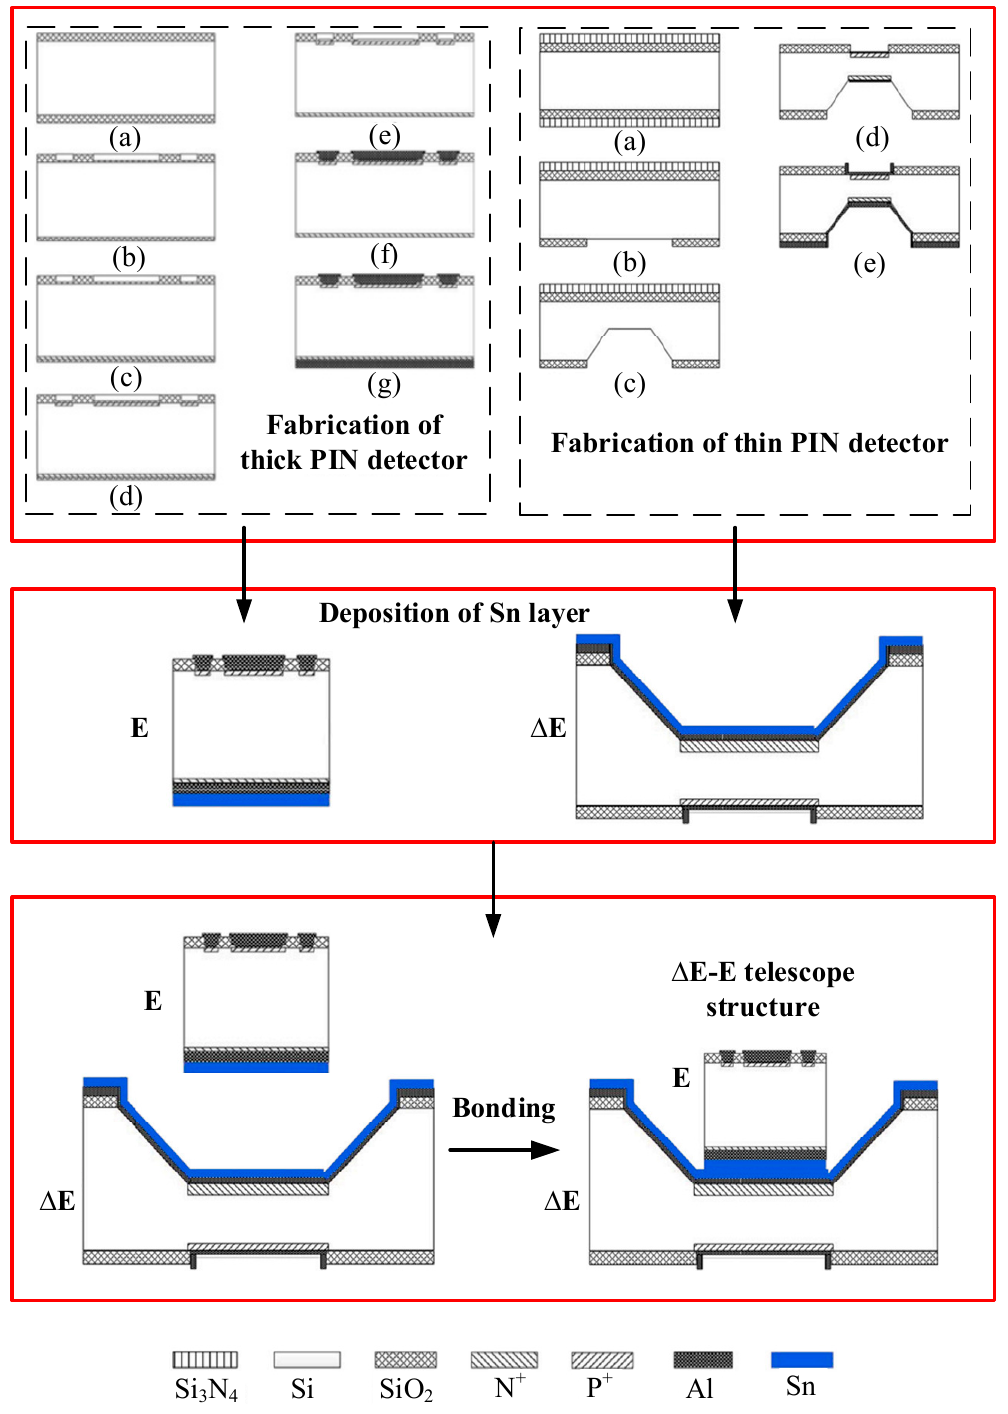
Figure 6. Fabrication steps of integrated PIN detector structure based on Al–Sn–Al bonding [7].